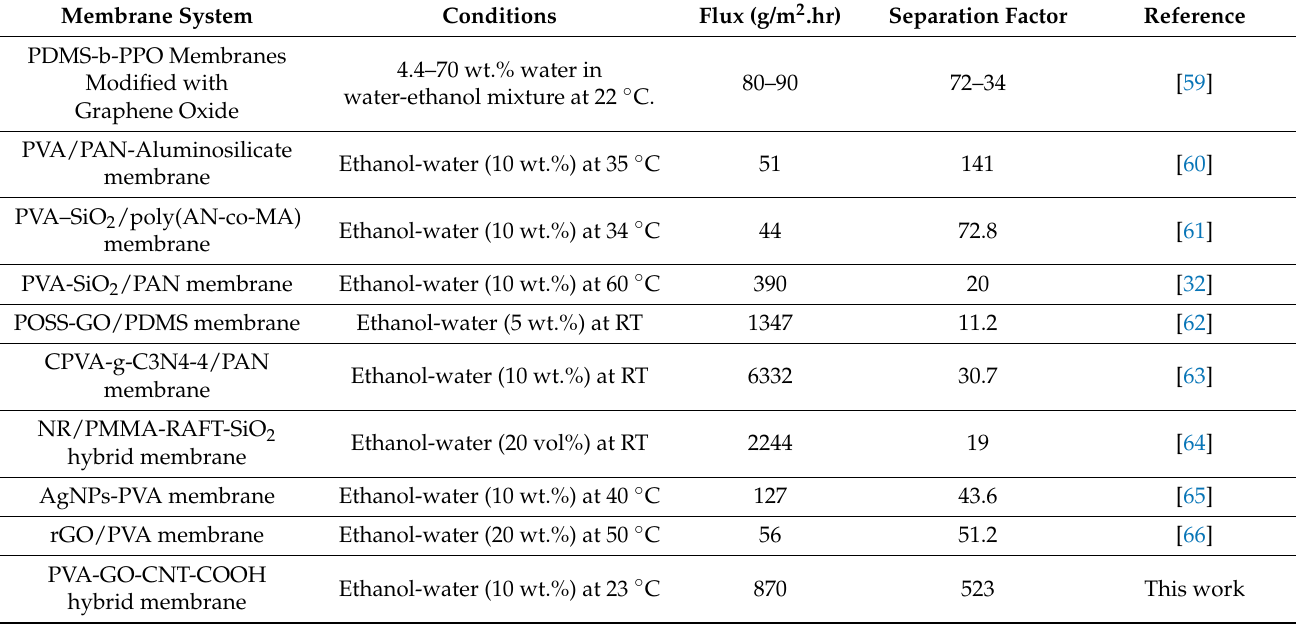
Table 1. Comparison of dehydration of ethanol through various